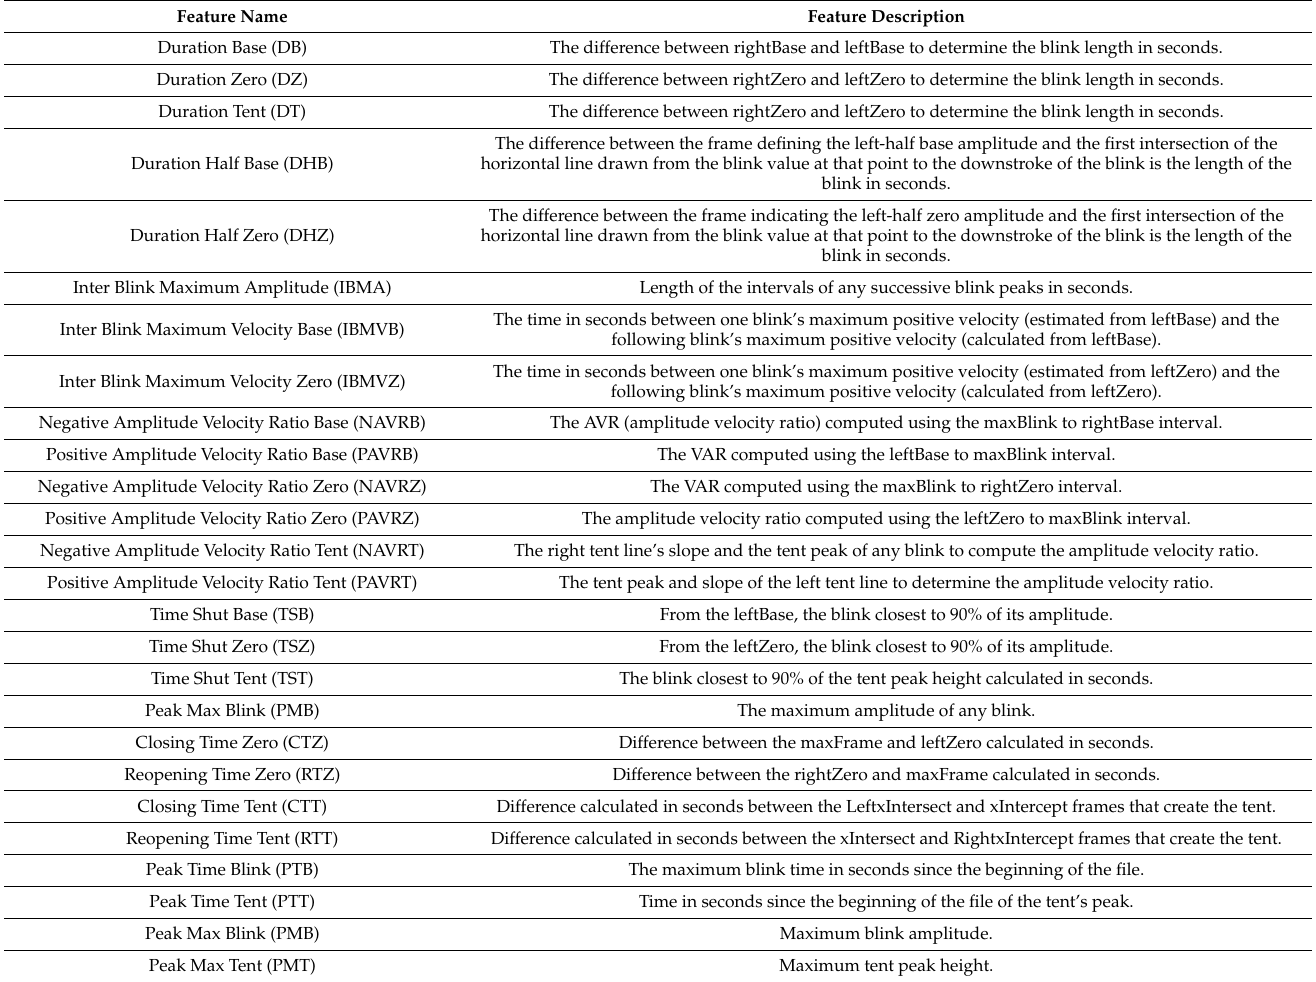
Table 2. Features from BLINKER and their